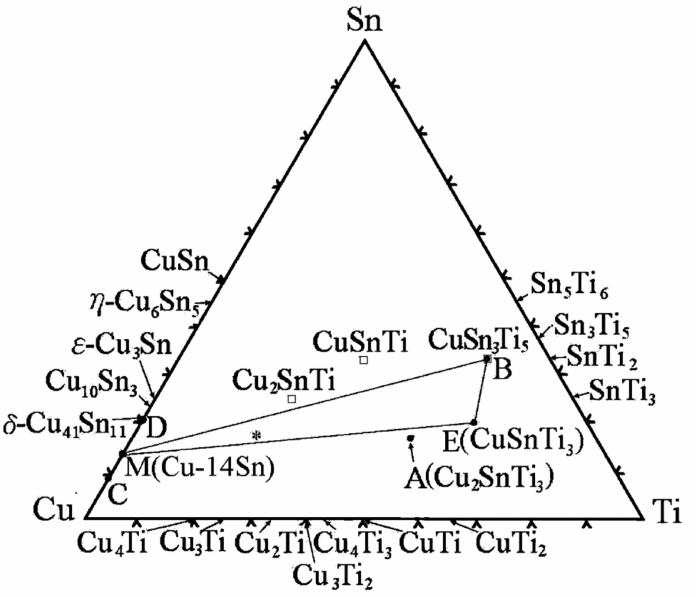
Figure 31. The phase relationship of constituent phases of Cu-23at. %Ti-17at. %Sn alloy in the ternary phase diagram of Cu-Sn-Ti when isothermally held for 10 h at 900 ◦ C